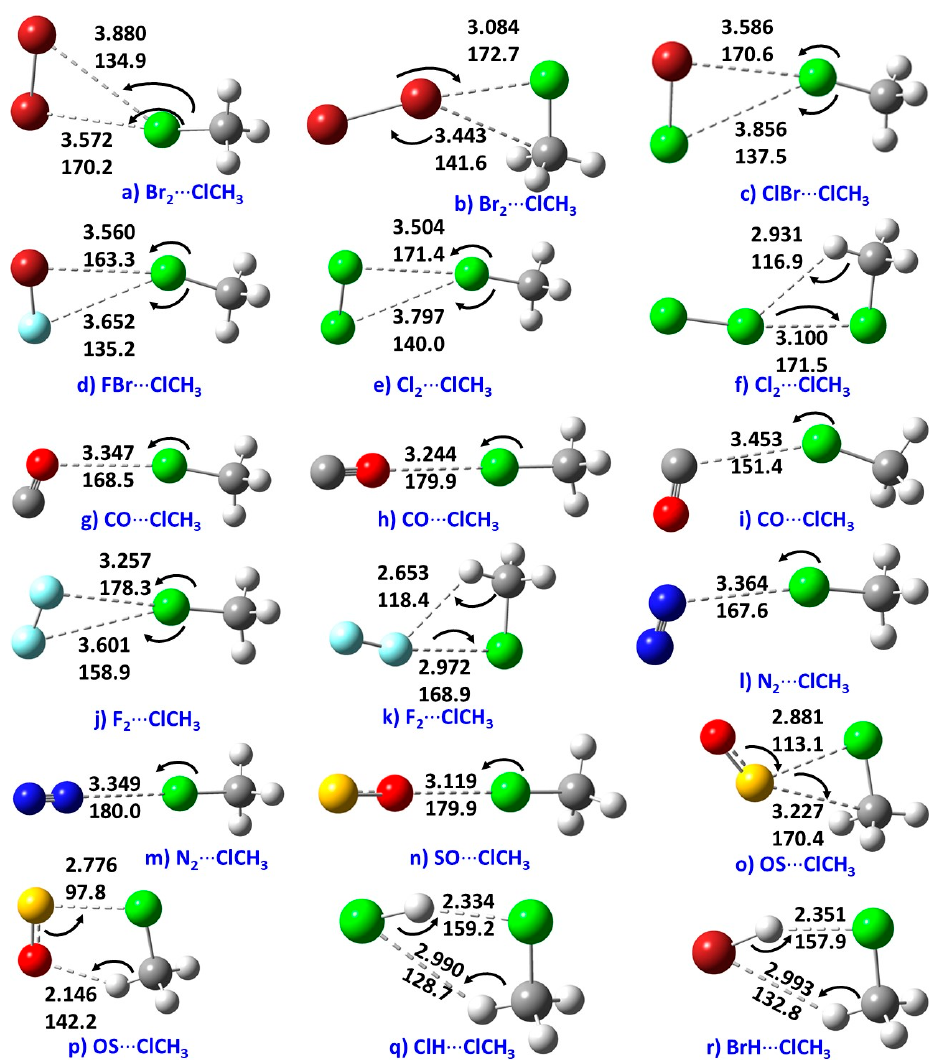
Figure 2. MP2 / aug-cc-pVTZ energy-minimized geometries of the 18 binary complexes of CH 3 Cl Figure 2. MP2/aug-cc-pVTZ energy-minimized geometries of the 18 binary complexes of CH 3 Cl examined in this study. The intermolecular distance in Å (upper entry) and the angle of approach